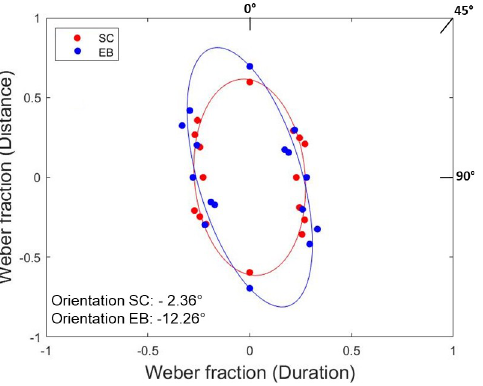
Fig 5. Ellipses of EB (in blue) and SC (in red) groups: For each ellipse, data points represent the JNDs of the psychometric functions plotted along each orientation. Ellipses oriented close to the 0˚ axis suggest temporal